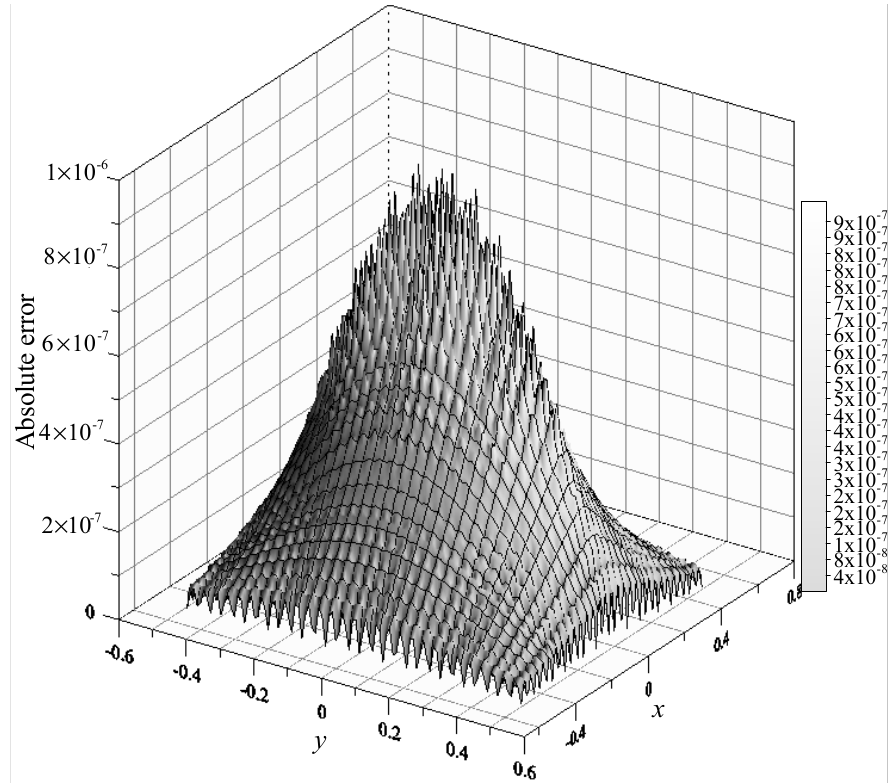
Figure 19. The absolute